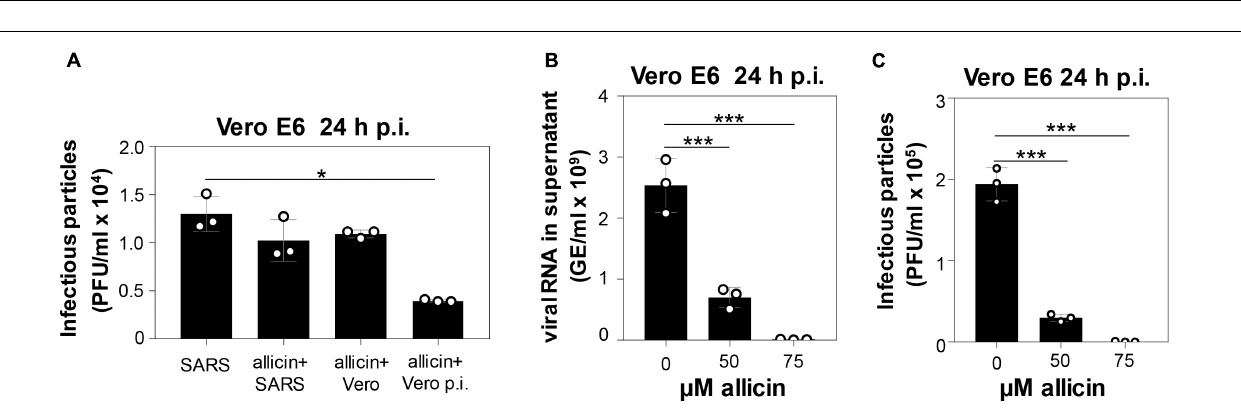
FIGURE 1 | Human Calu-3 cells are more resistant to allicin compared to Vero E6. (A,B) Cell viability of untreated and allicin treated Calu-3 (A) and Vero E6 cells (B) was measured after 24 h using the CellTiter-Glo R (cid:13) Luminescent Cell Viability Assay (Promega) according to the manufacturer’s instructions. The viability of the control without allicin was set to 100%. The viability of Calu-3 cells was not significantly decreased upon exposure to 100–200 µ M allicin, while concentrations of ≥ 100 µ M allicin interfered with Vero E6 cell viability. (C) The levels of glutathione (GSH) and glutathione disulfide (GSSG) were determined in untreated Calu-3 and Vero E6 cells using the GSH/GSSG-Glo Assay (Promega) according to the manufacturer’s instructions. The results are from 4 biological replicates with 3 technical replicates for (C) . Error bars represent the standard deviation (SD). p -values were calculated using an unpaired two-tailed t -test.* p < 0.05; ** p < 0.01.